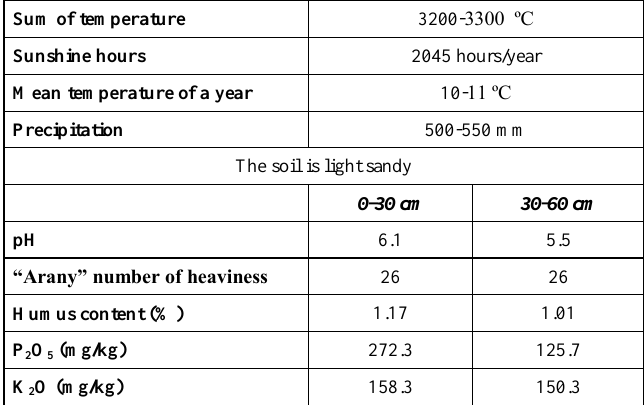
Table 1 . Ecological parameters of the experimental site (Debrecen-Pallag)